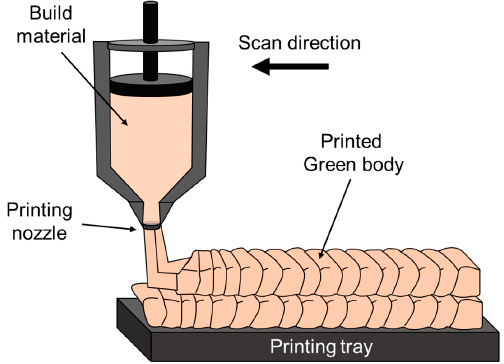
Figure 16. Schematic illustration of ME process using a plunger. Table 8. HEAs fabricated by ME process.